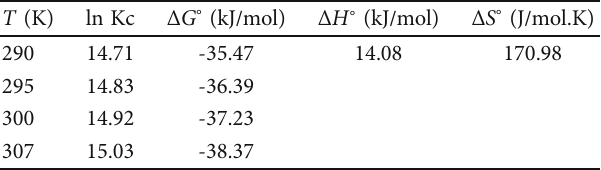
Table 4: Thermodynamic parameters of adsorption process.